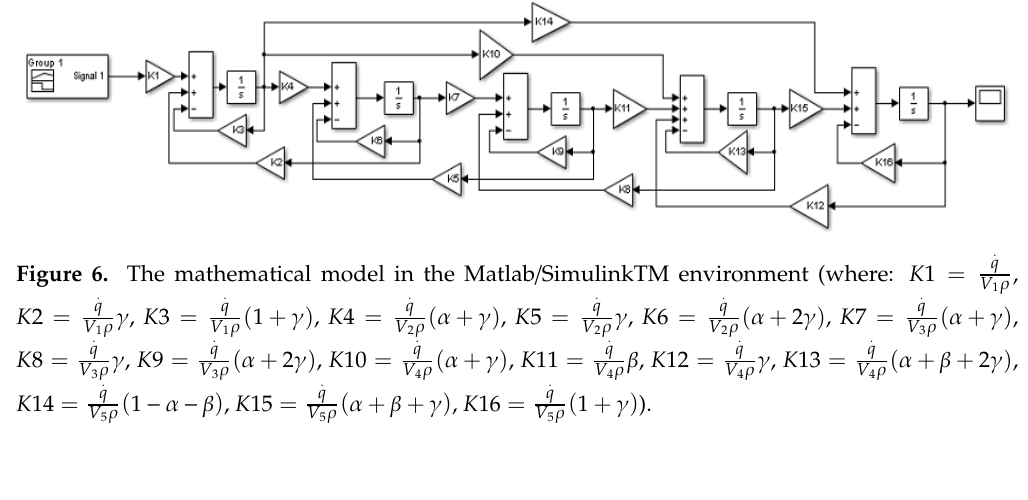
Figure 5. Mapping of the CFD results (for V =30 dm 3 ∙h −1 and N = 300 RPM) into a comaprtmental model ( V 1 —inlet subdomain; V 2 —upper turbine subdomain; V 3 —intensive mixing subdomain; V 4 —bottom turbine subdomain; V 5 —outlet subdomain). The parameters of the mathematical model: α , β , γ; volumetric flow rate: 10–60 dm 3 ∙s −1 , compartment volume: V 1 = 0.1 dm 3 ; V 2 = 2.2 dm 3 ; V 3 = 1.6 dm 3 ; V 4 = 2.2 dm 3 ; V 5 = 0.9 dm 3 .